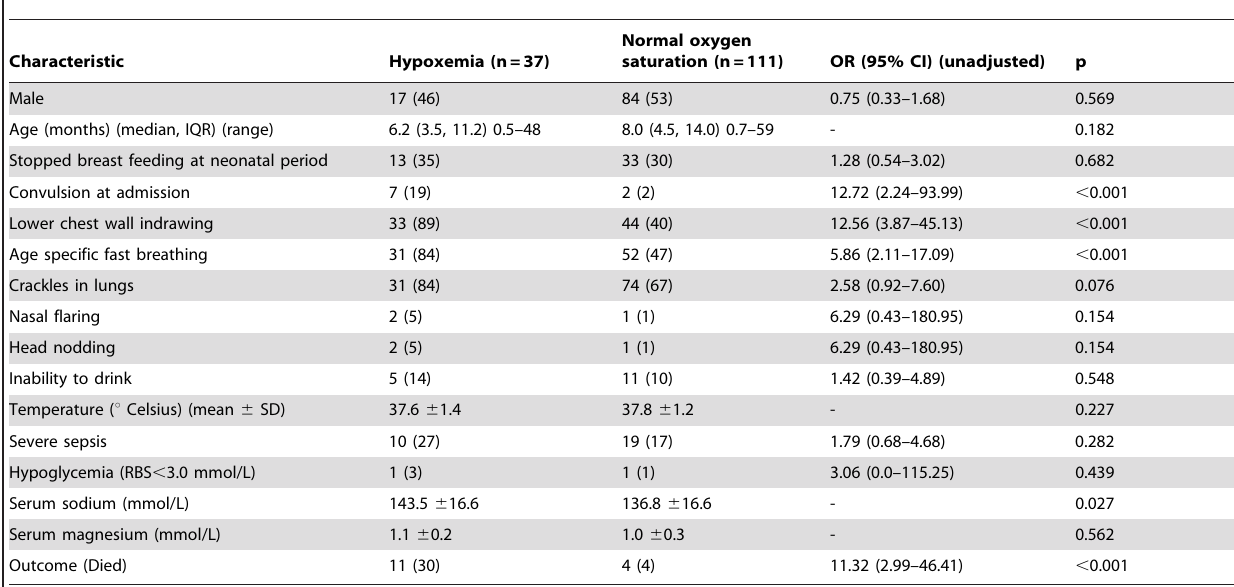
Table 1. Characteristics of the hypoxemic under-five children with pneumonia and SAM admitted to the ICU/HDU/ARI ward of the Dhaka Hospital of icddr,b.